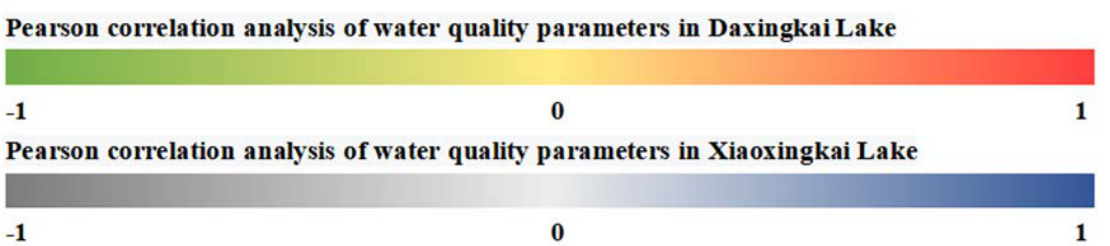
Figure 3. Pearson correlation analysis of water quality parameters in Xingkai Lake. ** means p < 0.001, * means p <